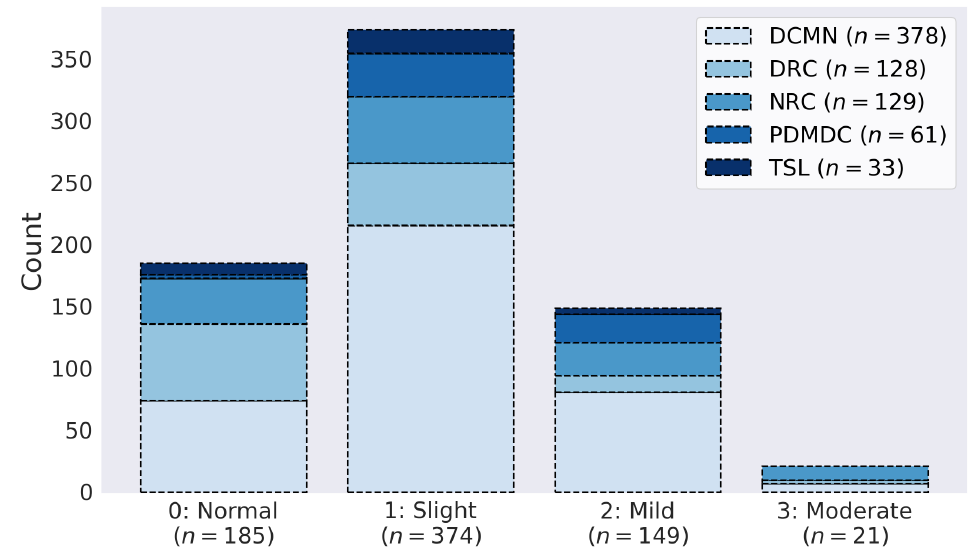
Figure 2. The distribution of UPDRS ratings across the five assessment centres. Severity scores were imbalanced, with low scores being more common than high scores, reflecting the distribution of ratings commonly encountered in the clinic [30]. DCMN: Department of Clinical and